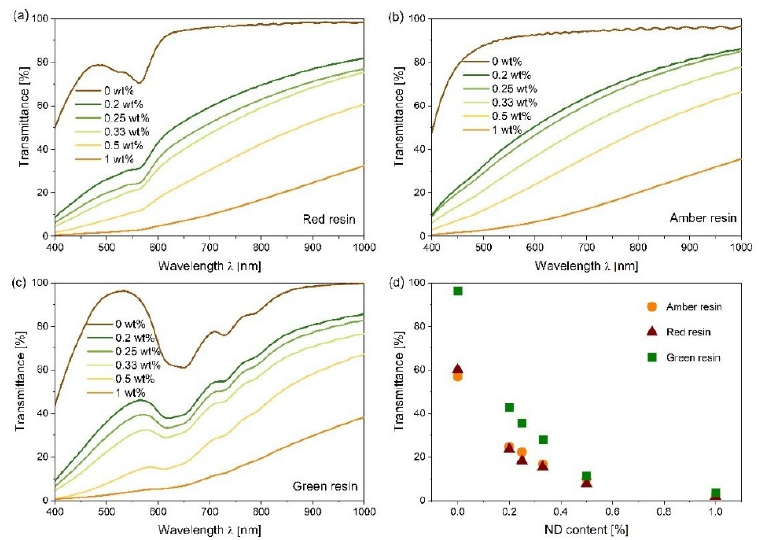
Figure 5. UV–Vis spectra of MDPs–polymer composites with amber resin ( a ), red resin ( b ), green resin ( c ), and comparison of the samples’ transmittance at 532 nm ( d ) (0 wt.% in above figures belongs to the pure polymer without MDPs).